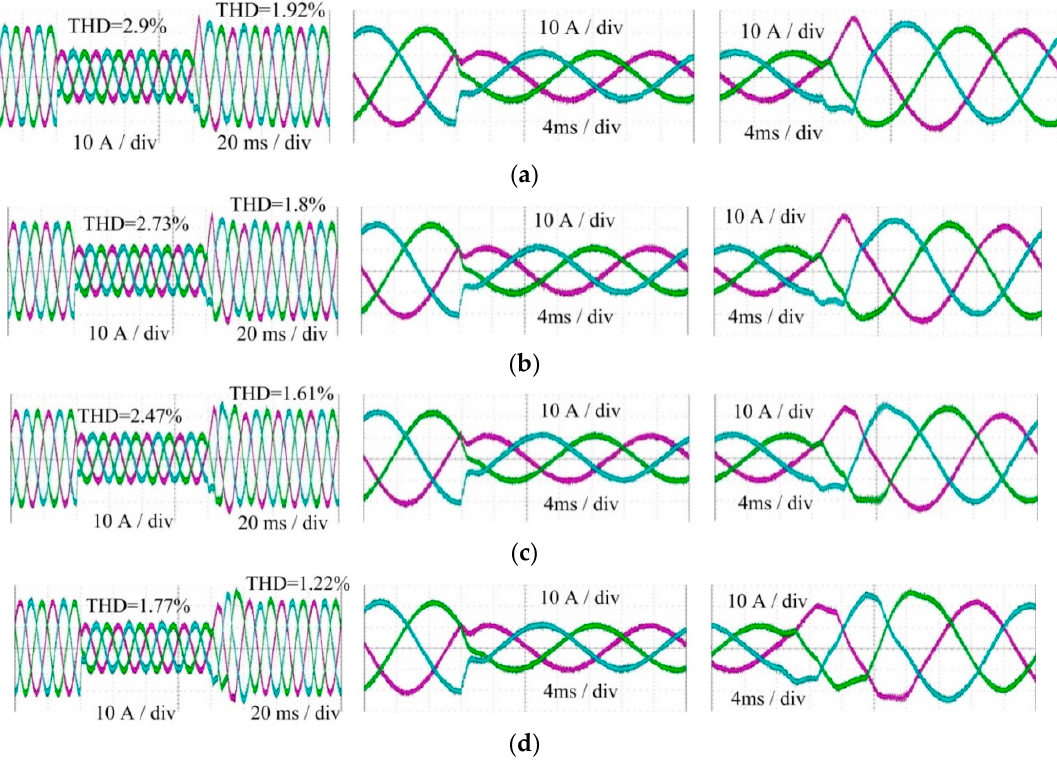
Figure 16. Current waveforms of the new inverter for various SCR. ( a ) L g = 1.0 mH (SCR = 45). ( b ) L g